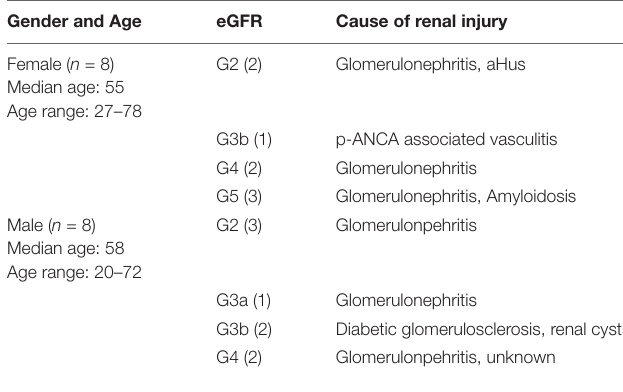
TABLE 1 | Demographic and health parameters of the human patient population. Gender and